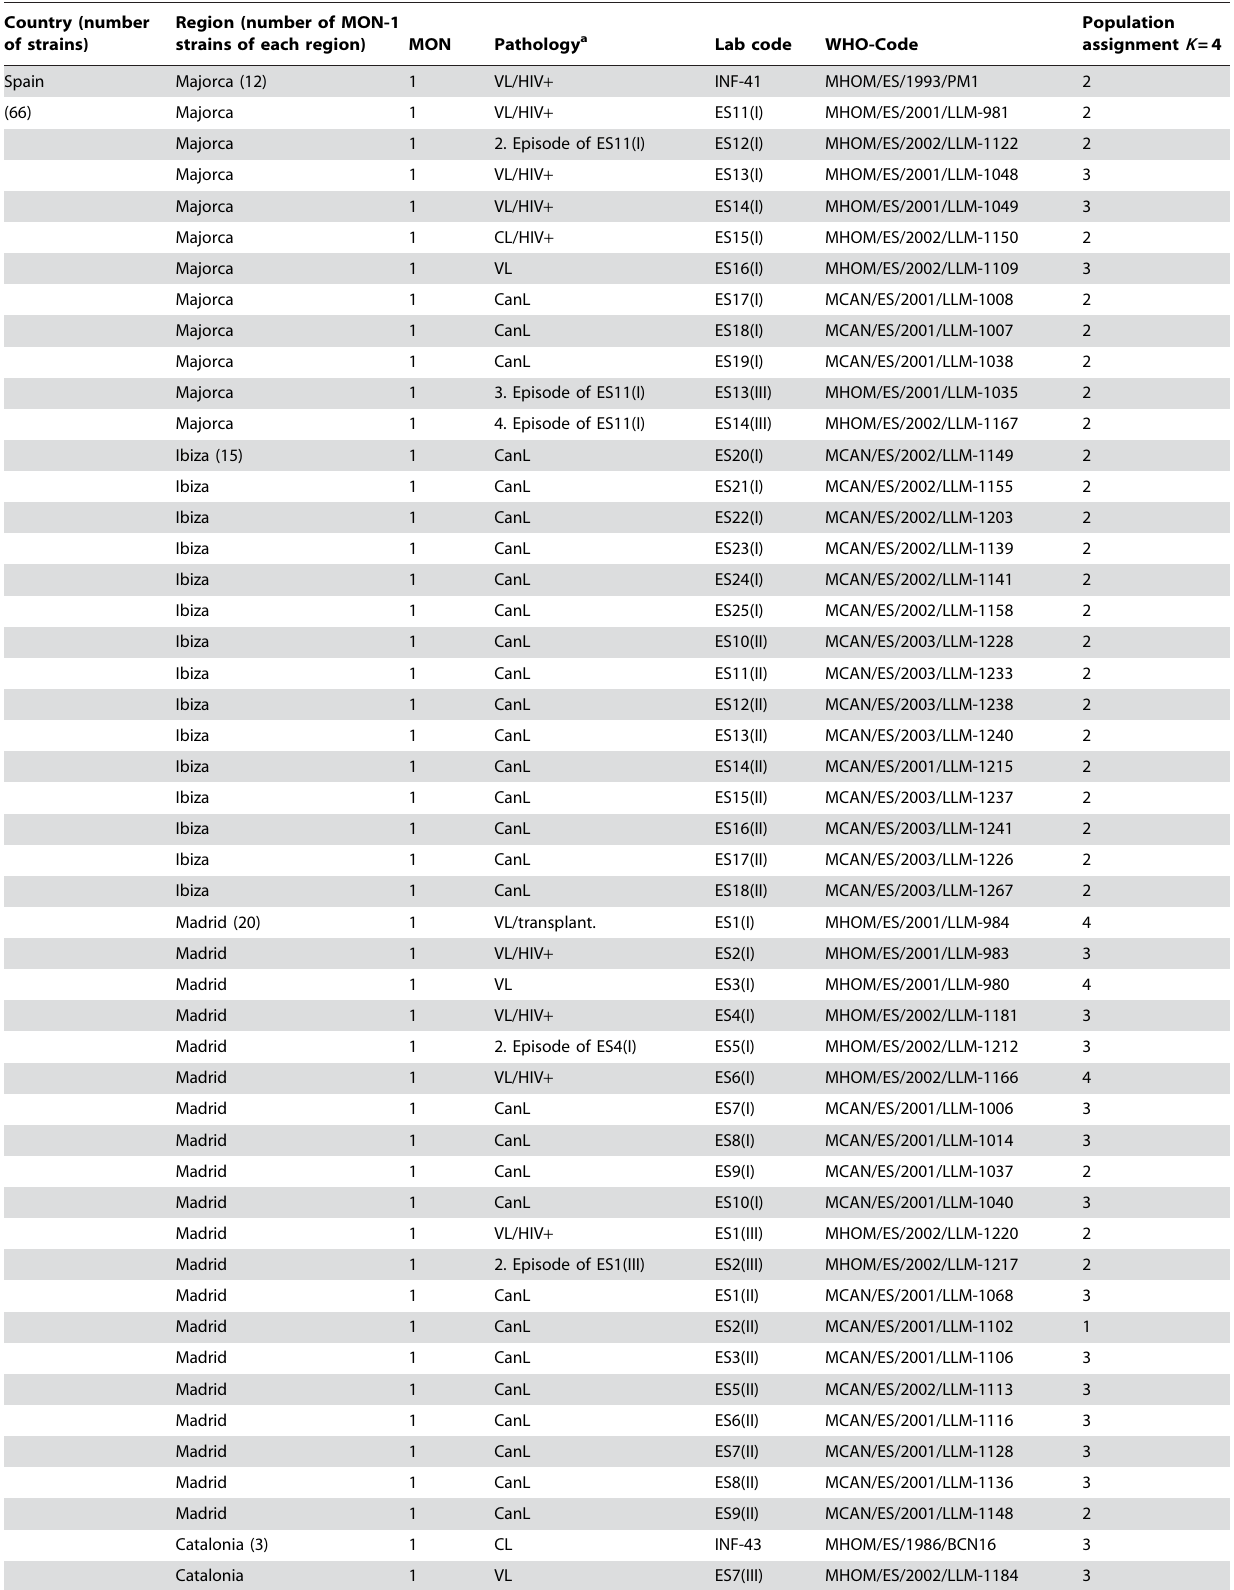
Table 1. Designation and characteristics of Leishmania infantum strains used in this study